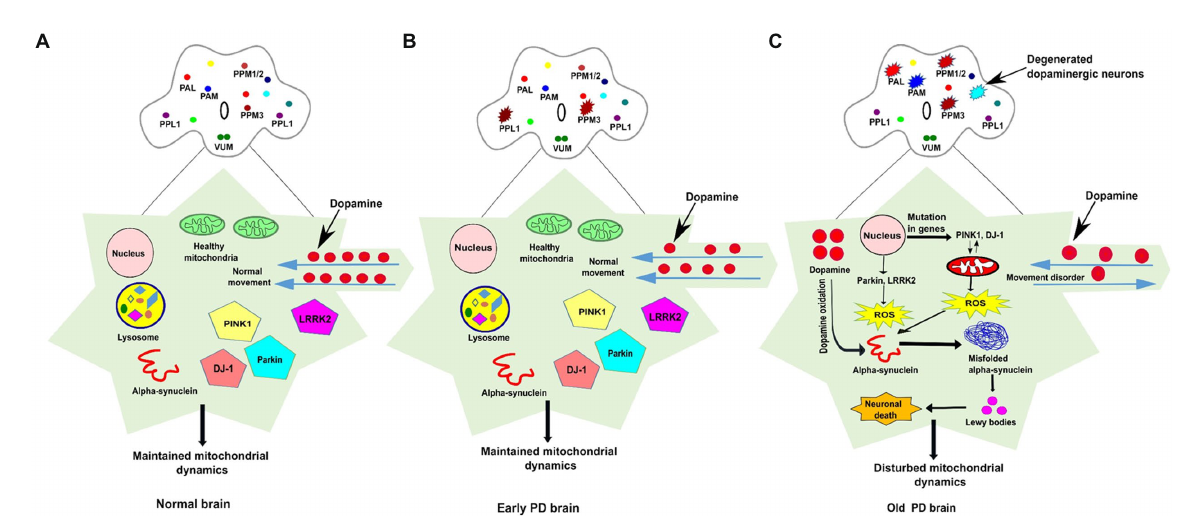
FIGURE 1 The schematic representation of dopaminergic neuronal clusters and PD-associated genes involved in mitochondrial function in normal, early and old PD affected brains of Drosophila . (A) The clusters of dopaminergic neurons are distributed all over the Drosophila brain. In the normal adult fly brain, healthy mitochondria and PINK1, Parkin, DJ1, and LRRK2 genes maintain the integrity of mitochondrial dynamics. The dopamine movement is found normal, and no loss of DA neurons observed in the healthy brain. (B) In the early PD, some (one to four neurons) of the DA neurons found degenerated in the young fly brain but proper PD-associated phenotypes are not observed. (C) In PD affected brain, the mutation in genes such as PINK1 and DJ-1 stimulate mitochondrial degradation which results in ROS overproduction, whereas dopamine oxidation promotes misfolded α -synuclein aggregation, the formation of Lewy bodies, and induces cellular toxicity which leads to neuronal death. Progressive degeneration of DA neurons (four-six neurons) has been observed in old-aged fly brain. The DA neurons clusters are labelled as PAL-Protocerebral Anterior Lateral; PAM - Protocerebral Anterior Medial; PPM - Protocerebral Posterior Medial; PPL - Protocerebral Posterior Lateral; VUM - Ventral Unpaired Medial; ROS-Reactive oxygen